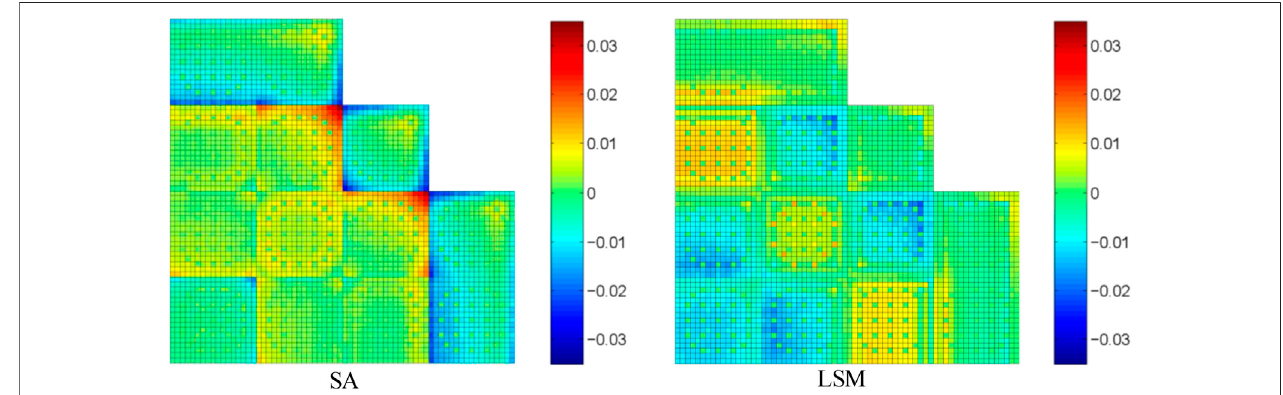
FIGURE 9 | Pin-power relative error